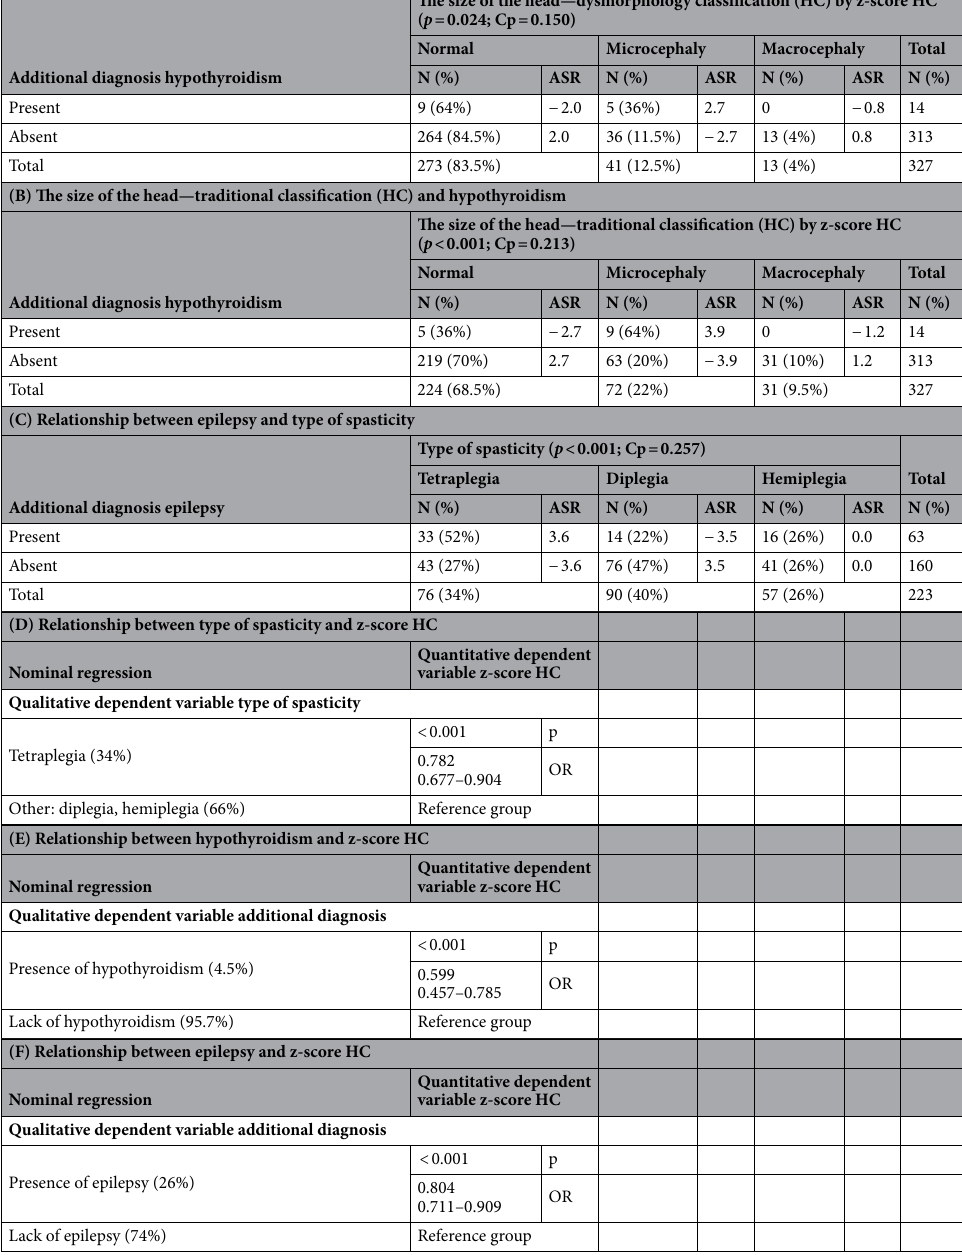
Table 5. The size of the head, hypothyroidism, epilepsy, type of spasticity. N numbers of patients; % percent; p probability value calculated by chi-square test of independence; Cp Pearson’s Contingency Coefficient C, Cp ≥ 0, values distant from 0 reflect some relationship; values approaching 1 correspond to a perfect association; ASR Adjusted standardized residuals, values > 1.96 reflect a greater number, and those below < − 1.96 correspond to a smaller number than a random distribution; OR odds ratio (95% confidence